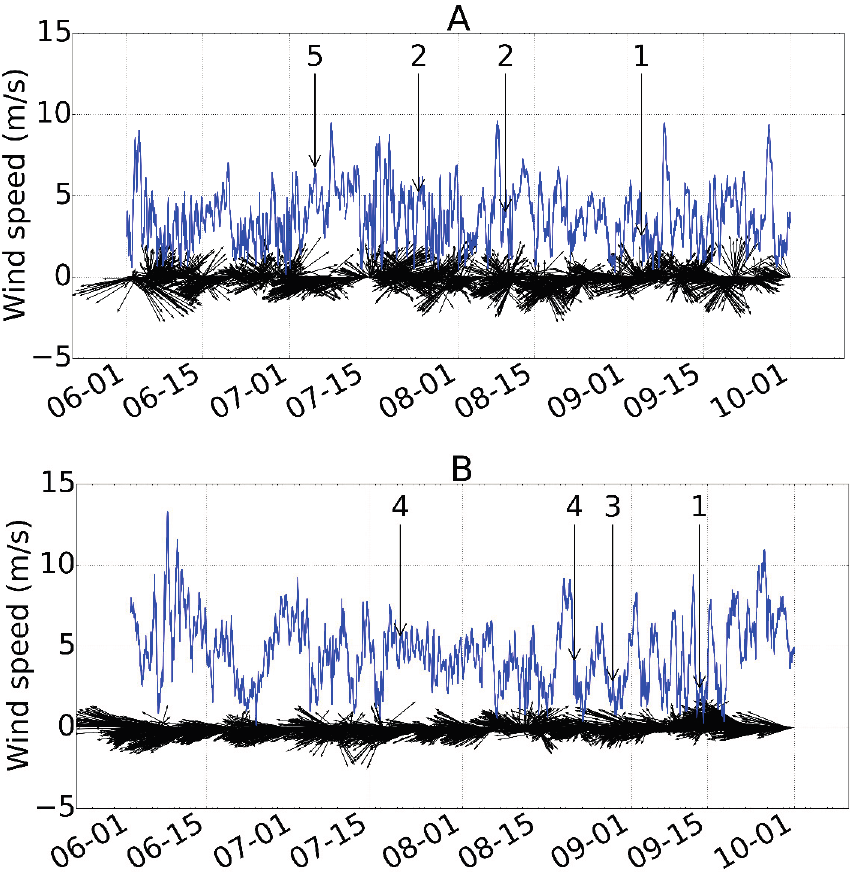
Figure 12. Time-series of wind speed and direction for the Teshekpuk study area